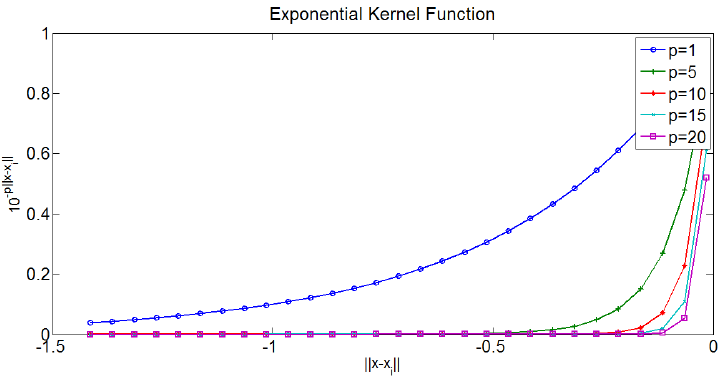
Figure 2. Exponential kernel function.